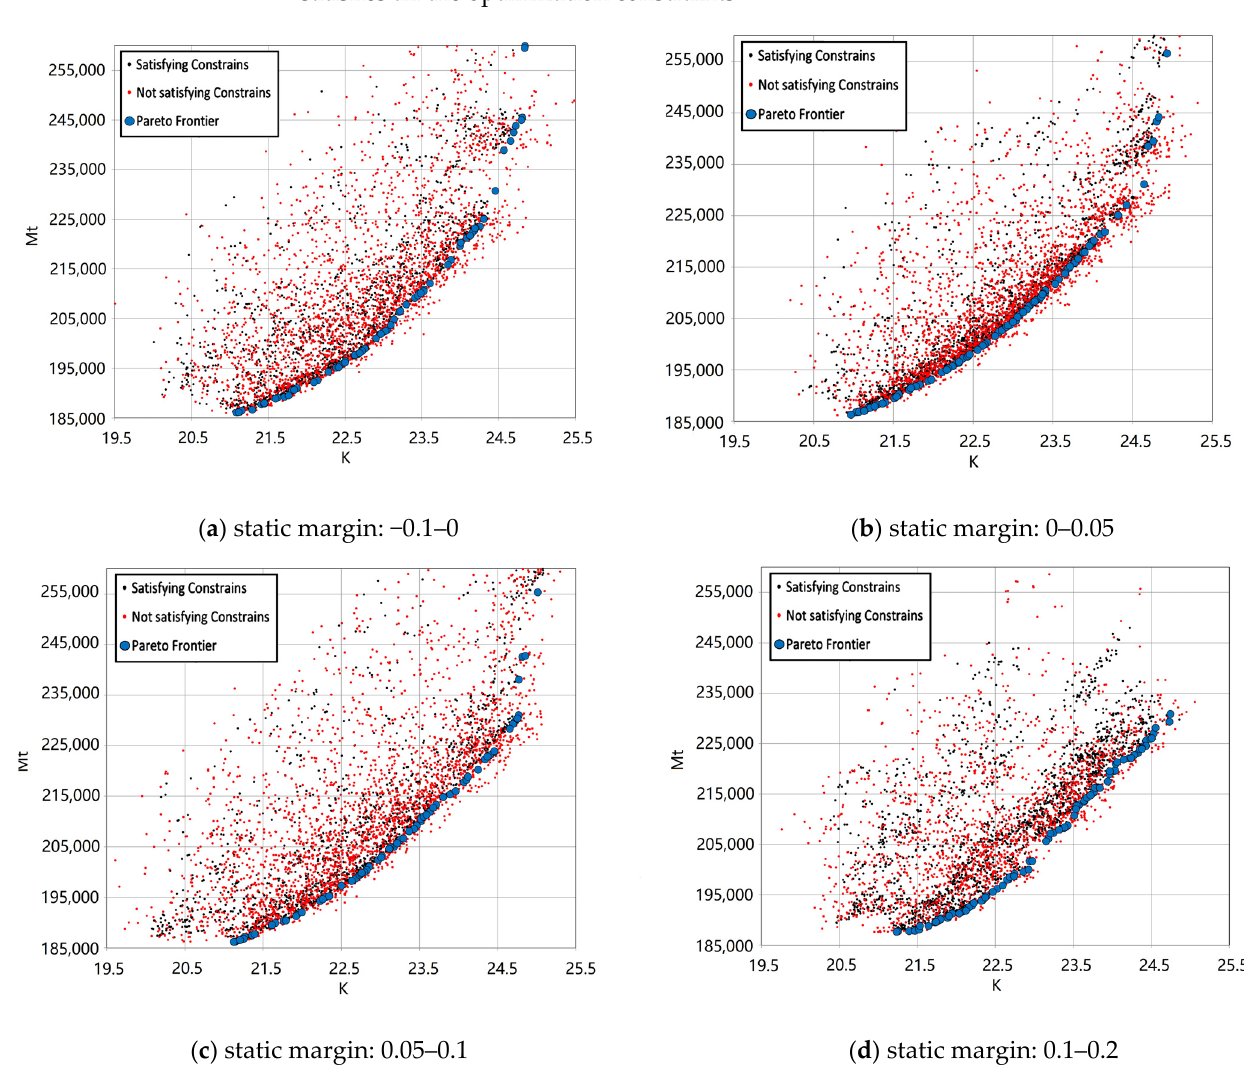
Figure 8. The optimization results under different static margin constraint.